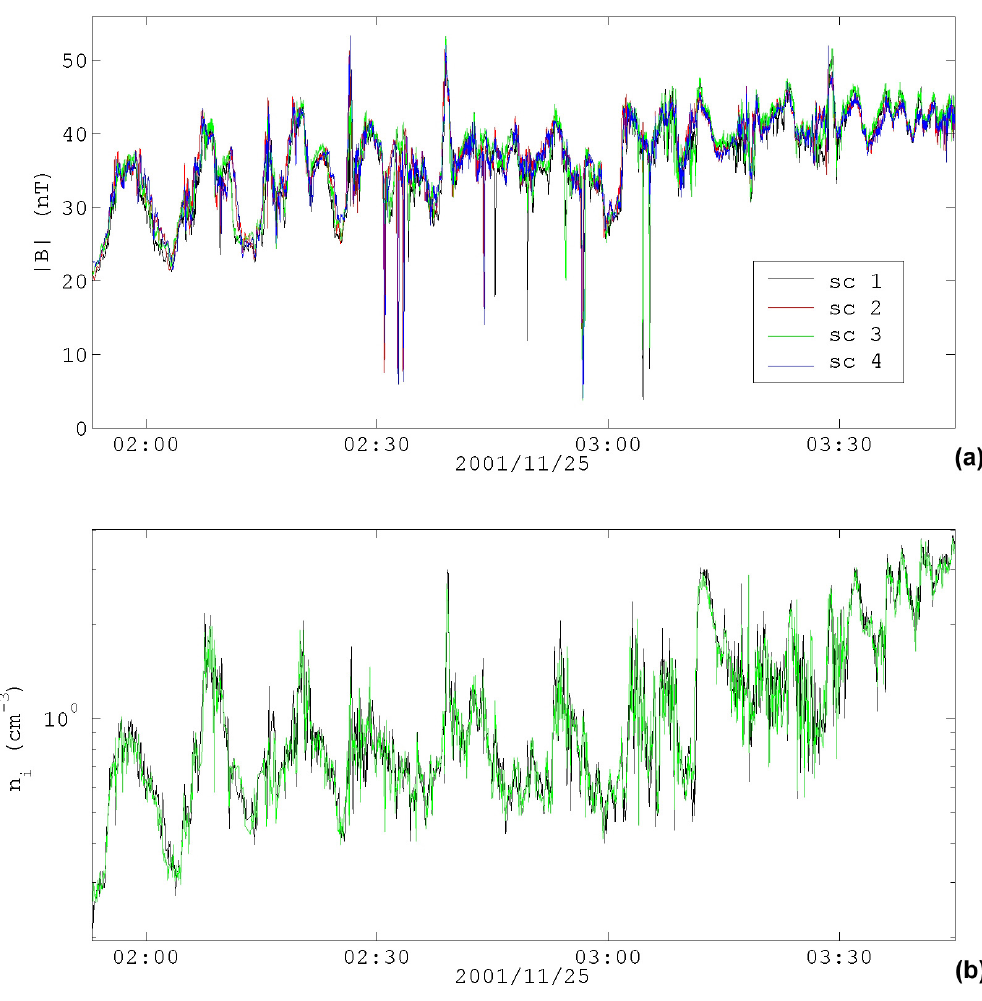
Fig. 3. Outbound pass on 25 November 2001, showing persistent large-amplitude waves for hours. ( a ) Magnetic field strength (FGM). ( b ) Ion density (CIS/HIA).